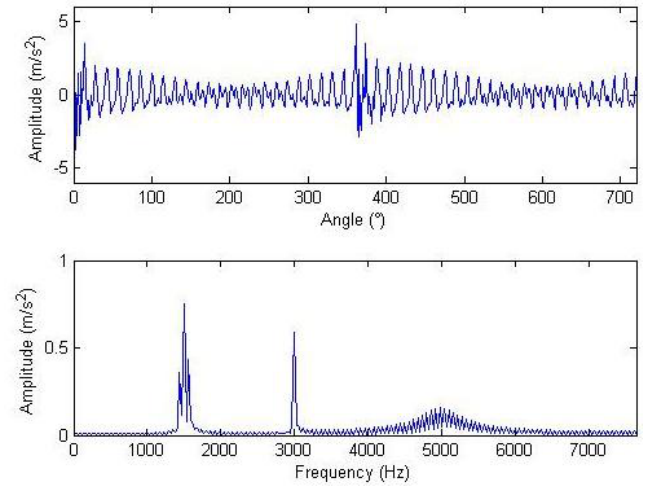
Figure 6. Waveform and frequency spectrum harmonic of reconstructed signals with hard threshold.